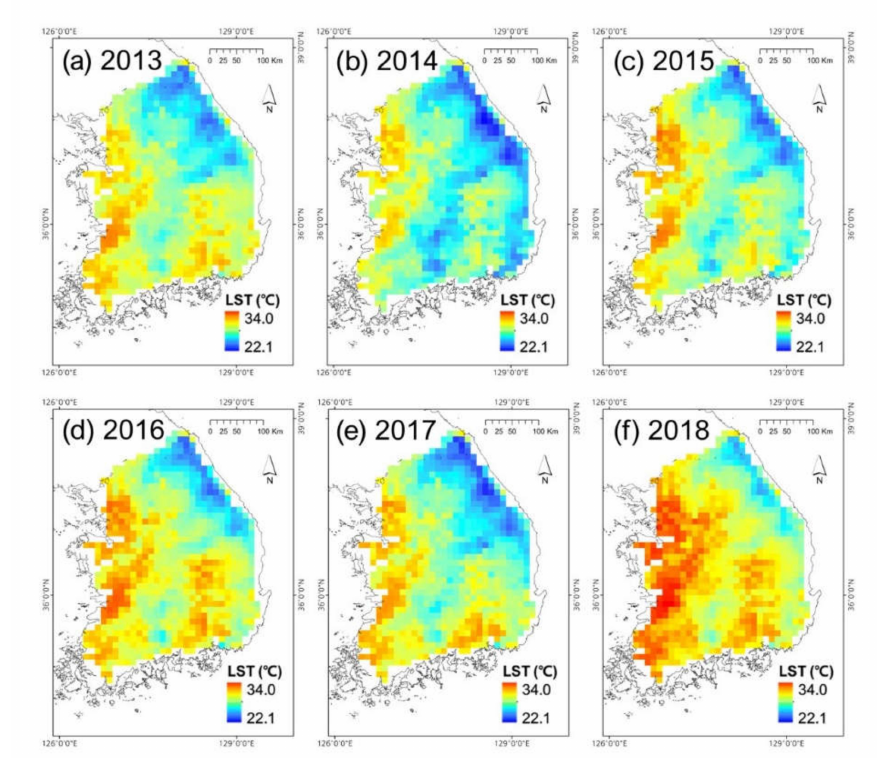
Figure 7. Spatial distribution maps of average estimated all-weather 10 km LSTs for scheme 1(S1) during July and August for each year; 2013 ( a ) to 2018 ( f ) for daytime.